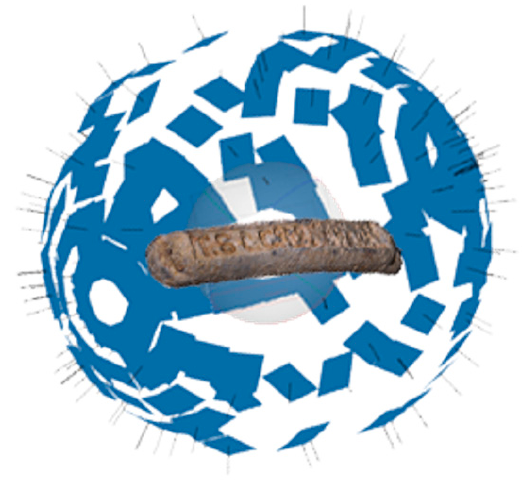
Figure 11. Sphere obtained from the positioning of the photographs. (Source: self-made).